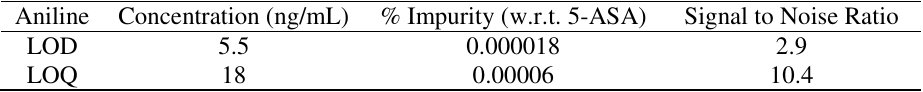
Table 4. Limit of detection and limit of